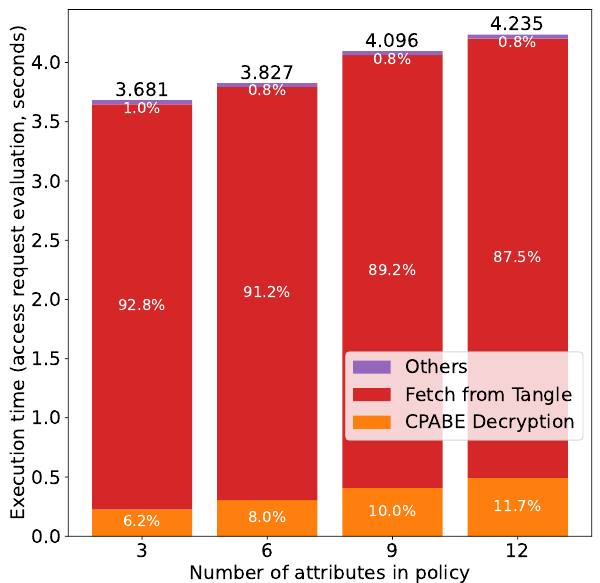
Figure 20. Access right verification time (Phase 2) vs. number of attributes.